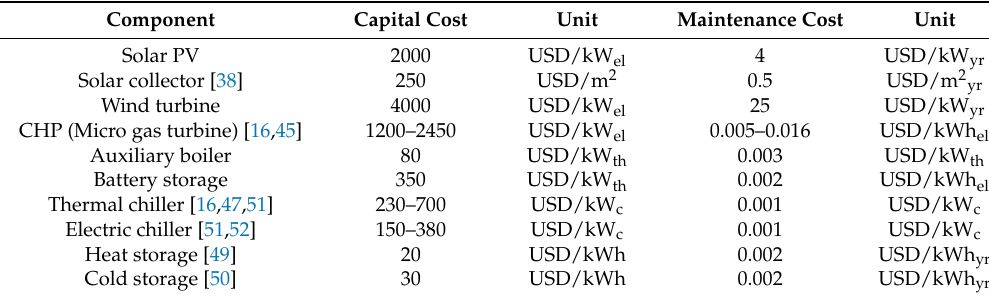
Table 3. Capital cost of each component *